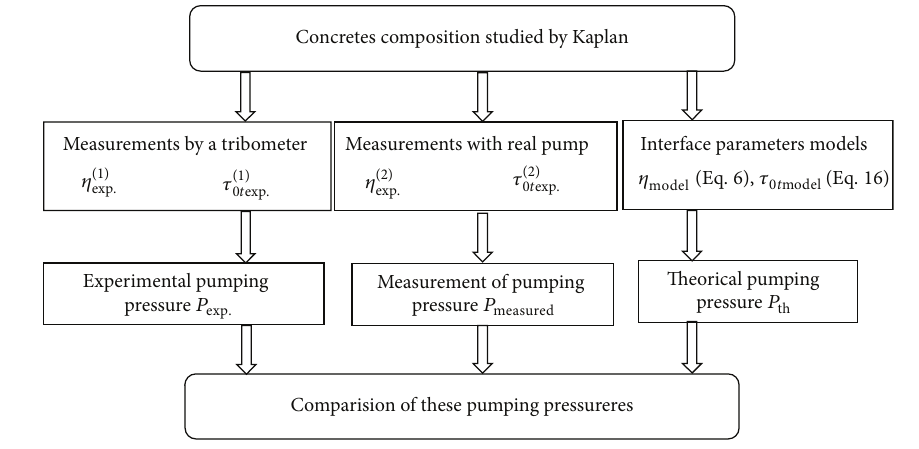
Figure 2: Schema of comparison of the pumping pressures.